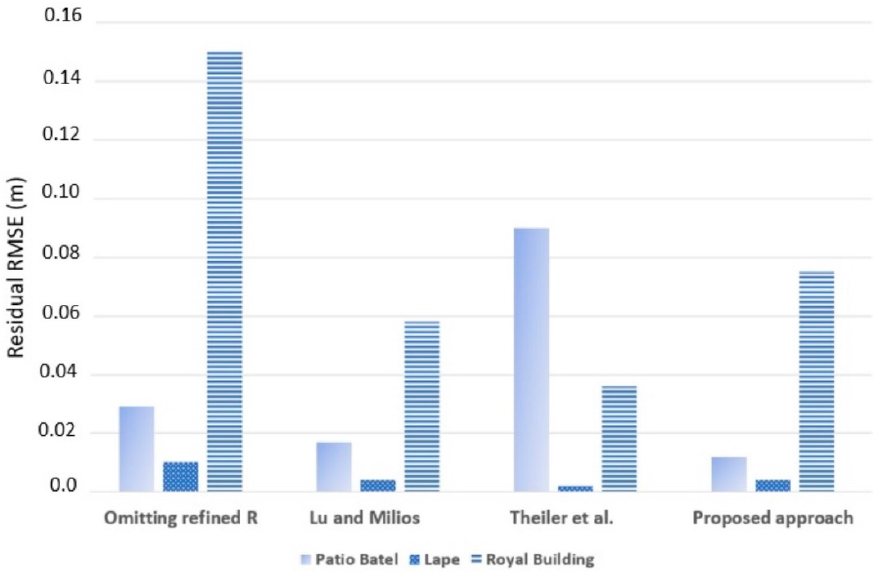
Figure 9. Comparison of proposed method with three approaches.